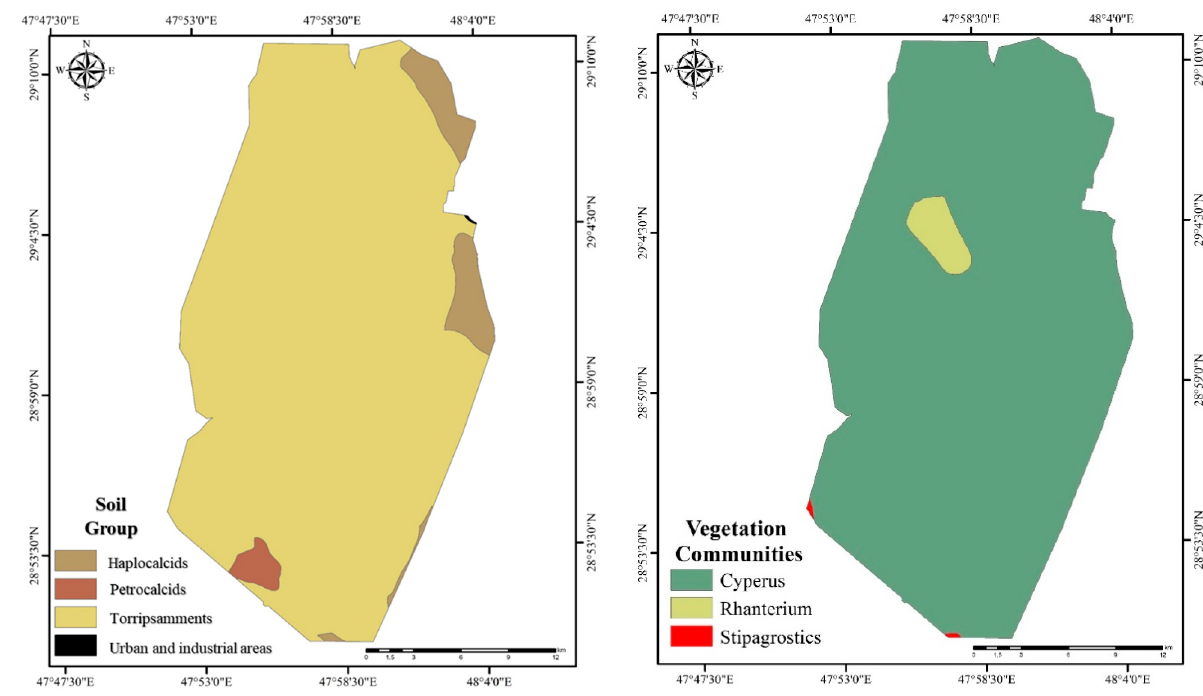
Figure 2. Soil group and vegetation community maps of Al-Burgan oil field [17,18]. Table 1. Number of samples, sampling methods, and sampling depth for the different categories of contaminated sites.